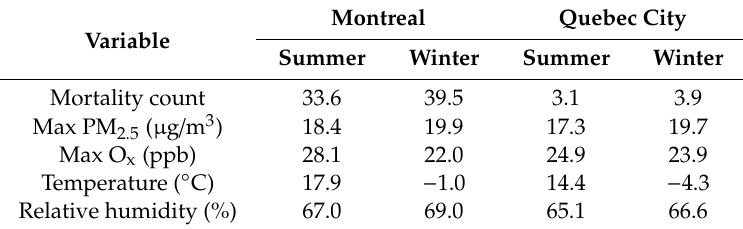
Table 1. Mean daily values of each variable considered in the present study. PM 2.5 = fine particle matters; O x = combined oxidant capacity of ozone and nitrogen